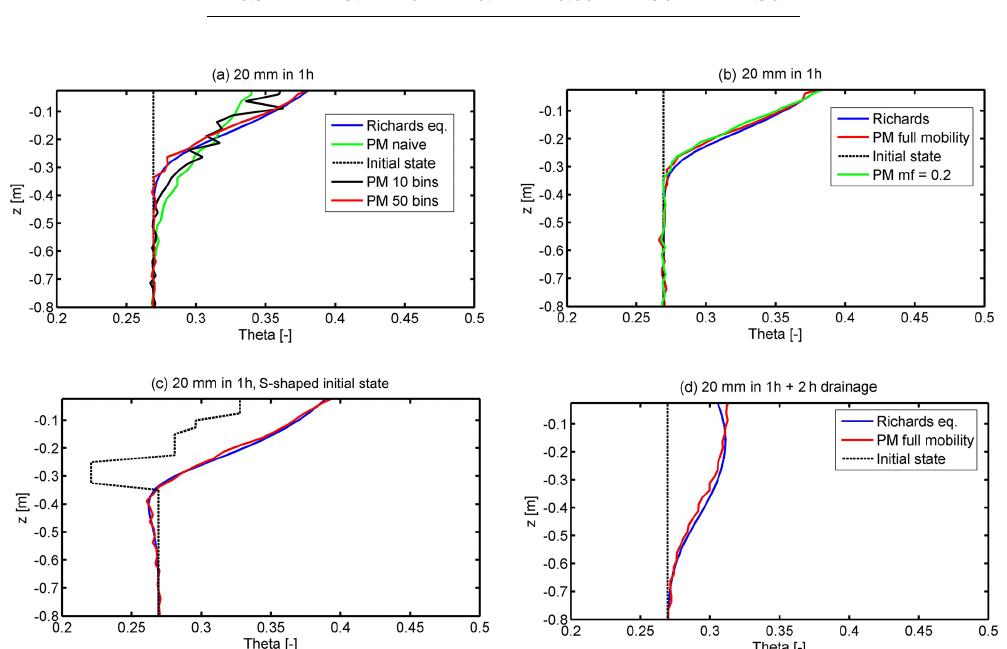
Figure 2. Final soil moisture profiles simulated for the sandy soil with the naive random walk (a) and the particle model (PM) using a different number of bins. Panels (b) and (c) compare the particle model to the Richards equation for a block rain of 20mm starting from the uniform initial state (b) and the S-shaped initial state (c) ; mf = 0.1 denotes the mobile particle fraction. Panel (d) presents the same case as (b) after 2h of additional drainage. The dashed grey line marks the initial soil moisture